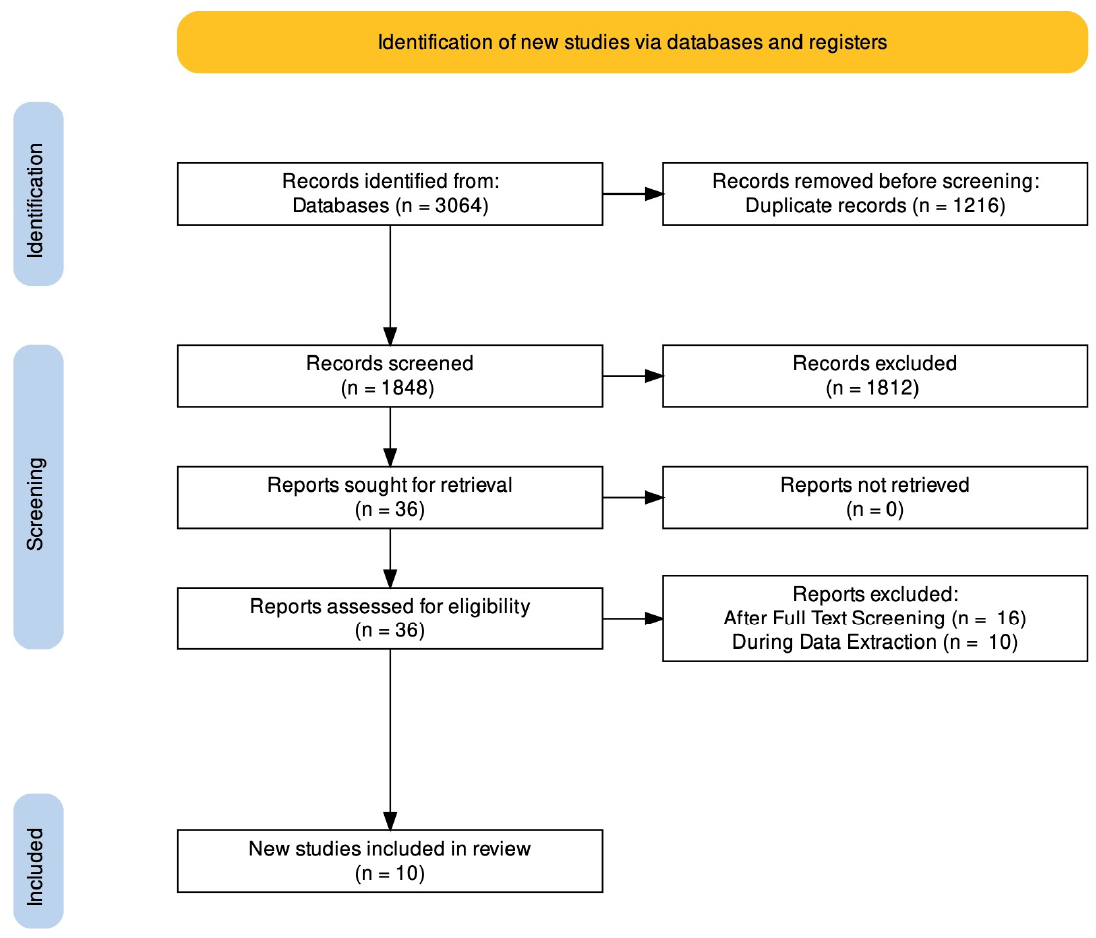
Figure 1. PRISMA 2020 flow diagram showing the search strategy, the number of records identified, and the number of included/excluded studies.